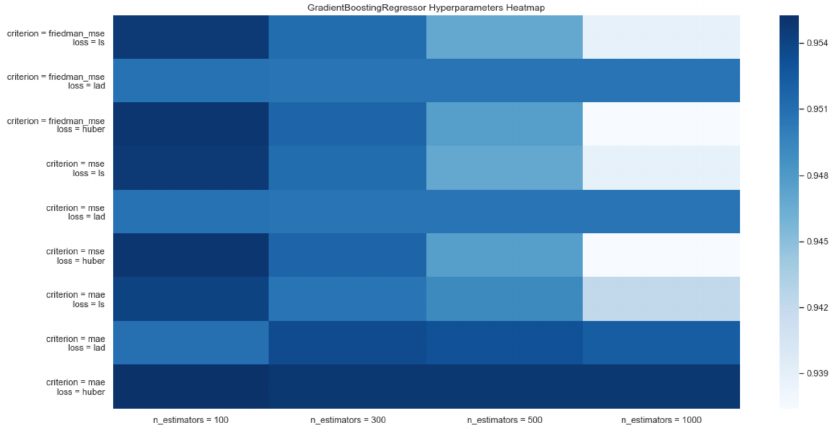
Figure 12. GradientBoostingRegressor Hyperparameter Heat Map.